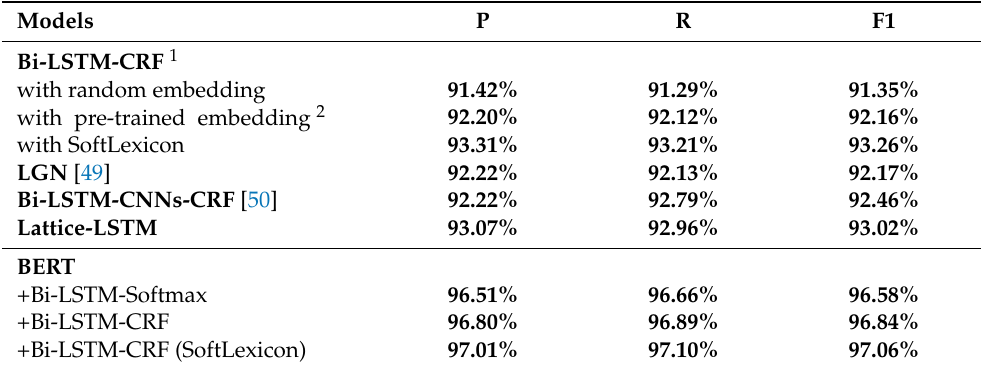
Table 5. Experimental results of nine different models on the NLPCC2016 dataset. The upper part is the model without using BERT, and the lower part is the model using BERT. The result of all models is from our